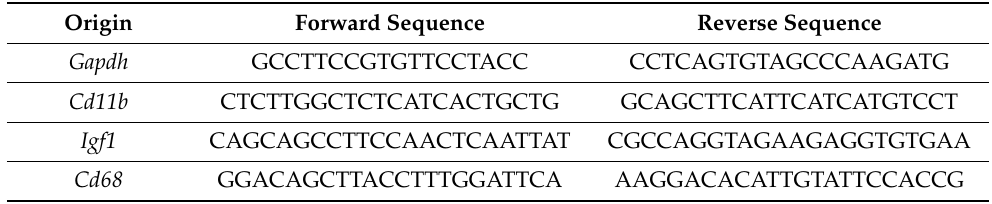
Table 1. SYBR Green RT-PCR primers for mRNA quantification: Mus musculus .